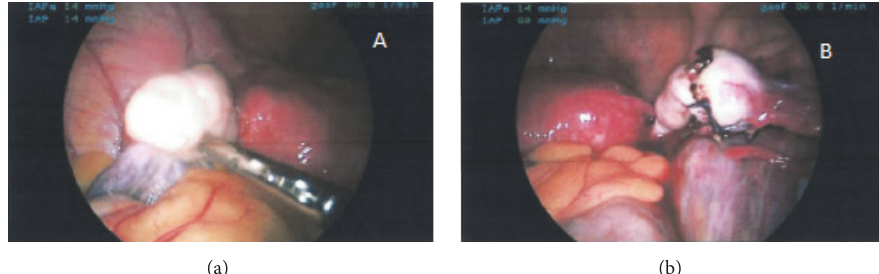
Figure 2: Intraoperative findings. (a) Ovarian ectopic. (b) Wedge